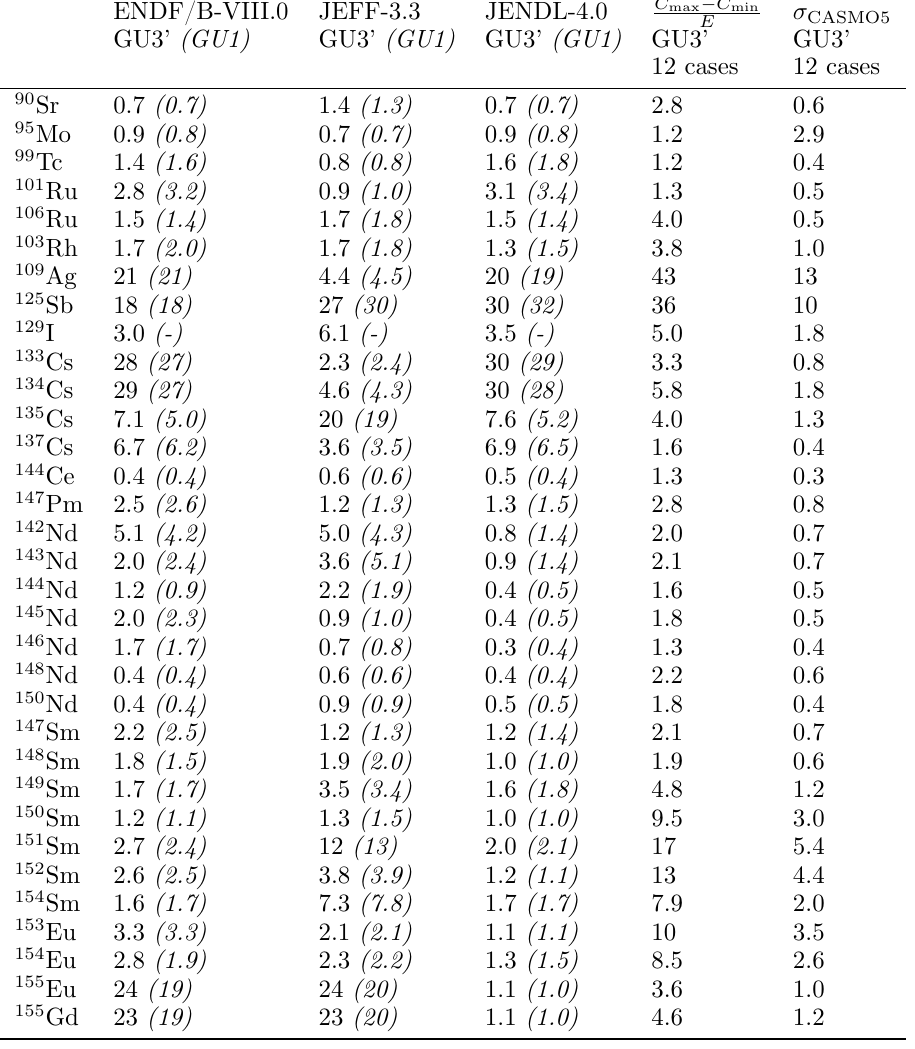
Table B.3. Same as Table B.2 but for fission products.